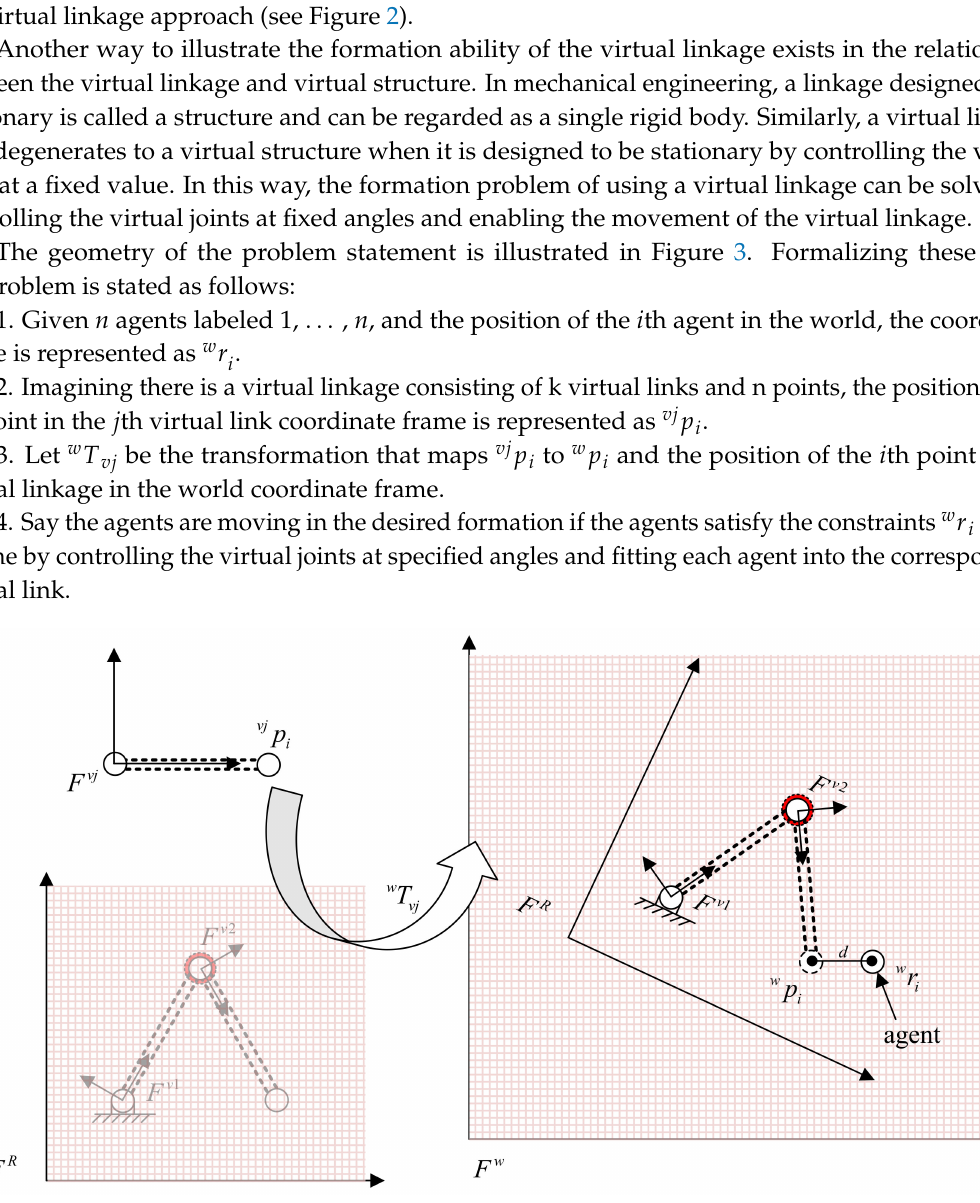
Figure 3. Geometry of the virtual linkage definition: F vj , F R , F w are the reference coordinate frames of the j th virtual link, virtual linkage and world, respectively. The point p i belongs to the j th virtual link and is mapped from vj p i to w p i through the transformation w T vj . The agents act as a whole